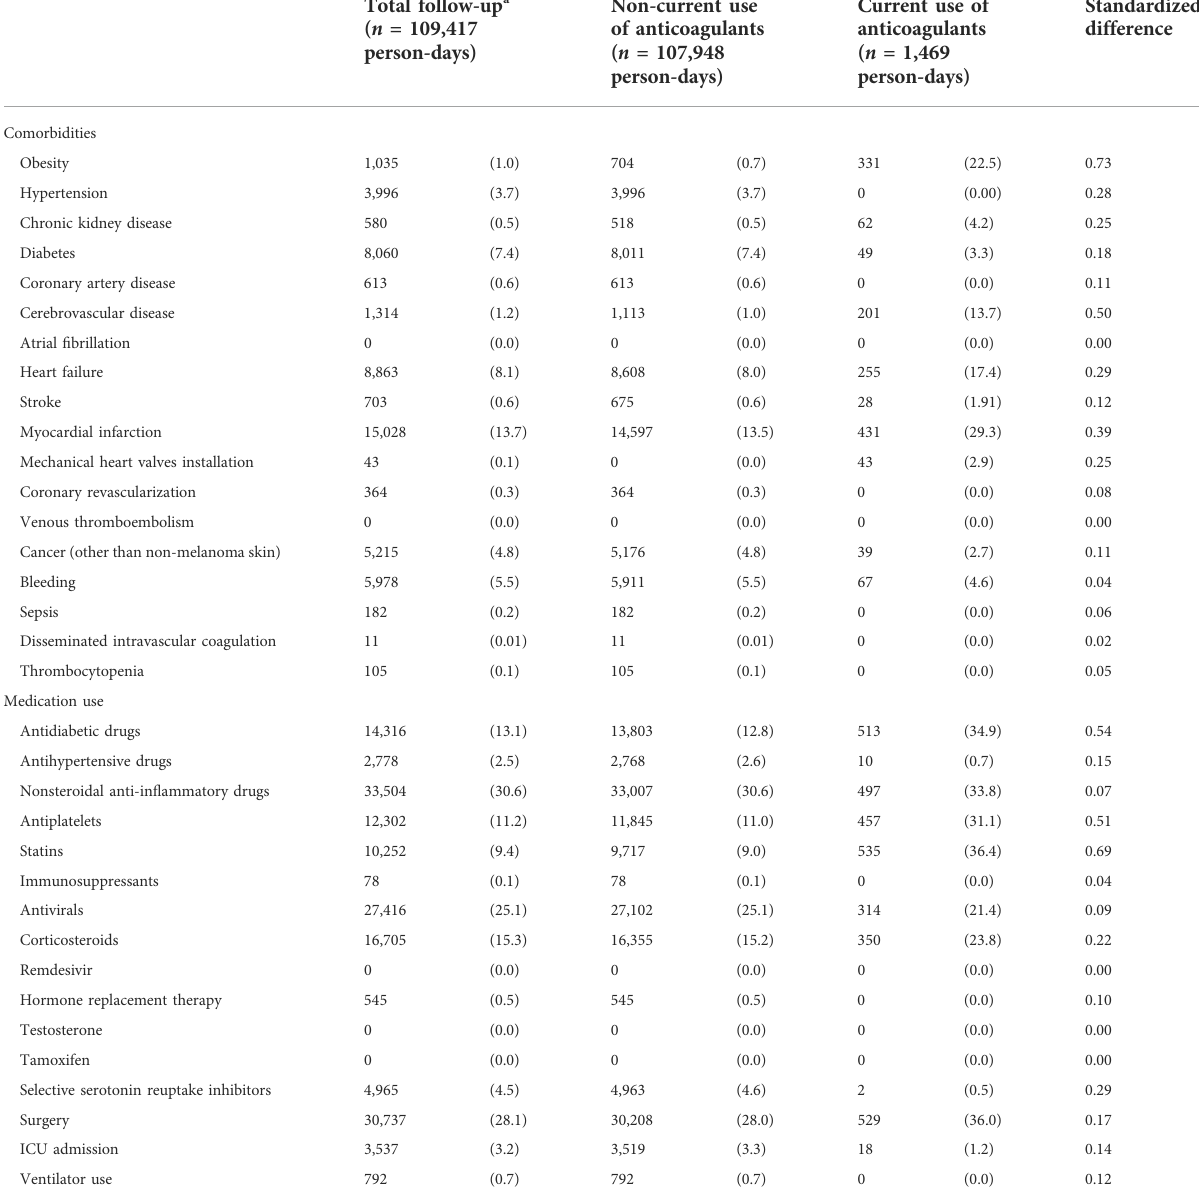
Total follow-up